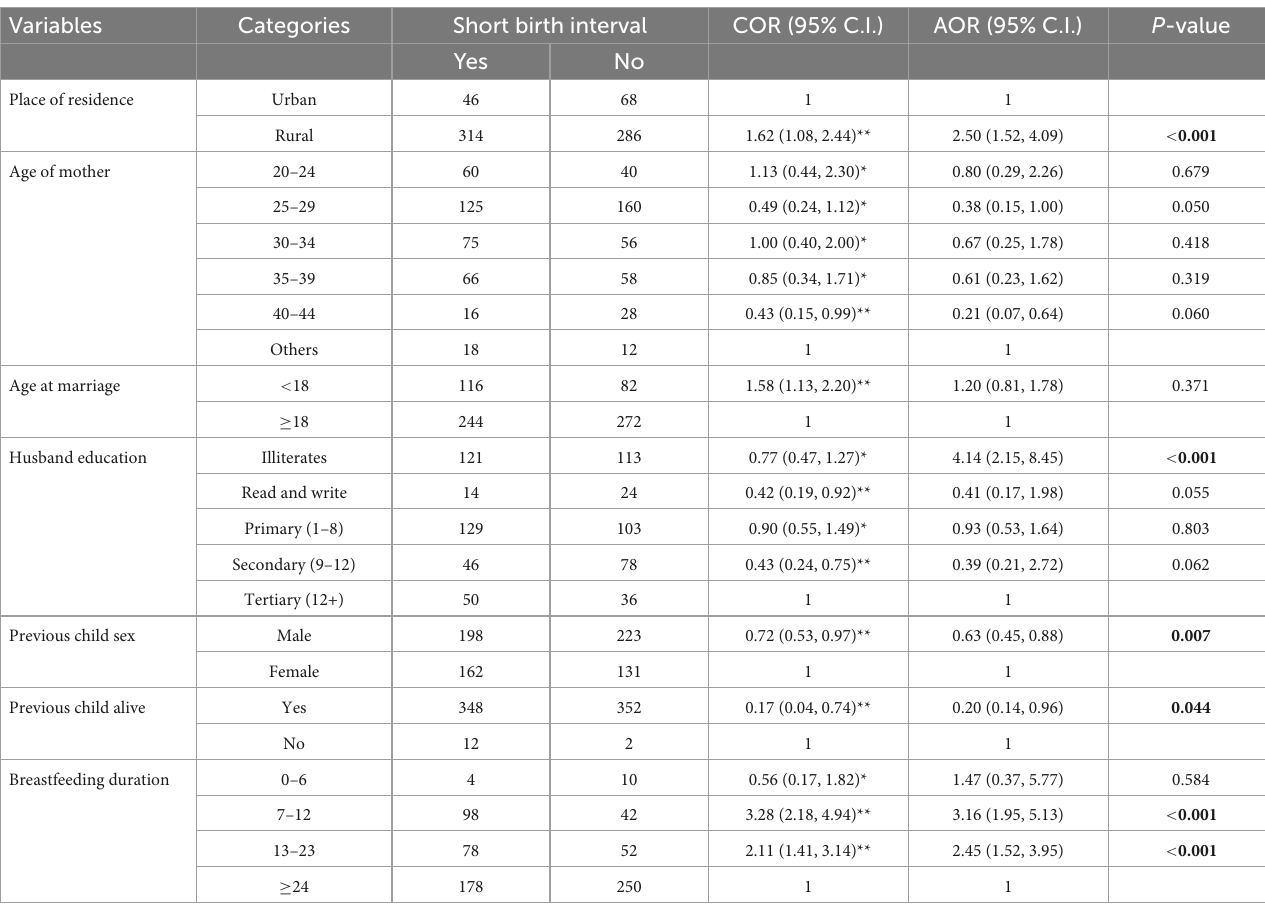
TABLE 2 Factors associated with short birth interval among child bearing age women in the Gedeb Hasasa district of the West Arsi zone, Ethiopia ( N = 714).